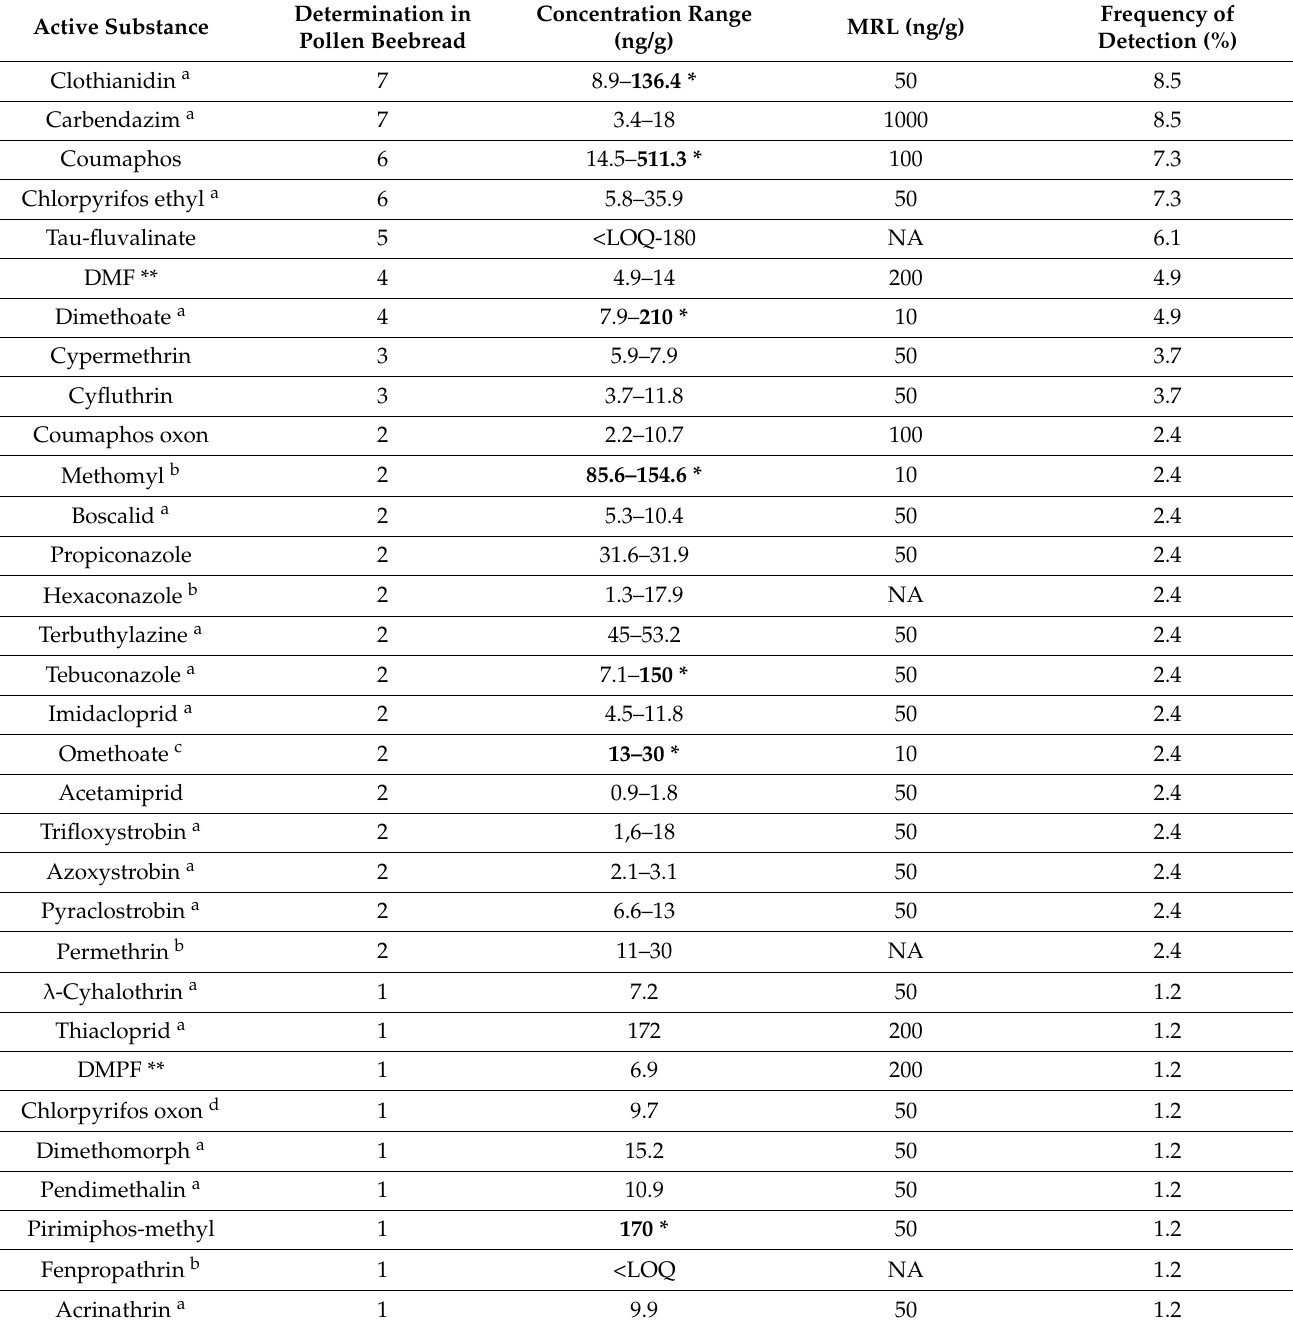
Table 2. Active substances, determinations, and concentration ranges in pollen beebread